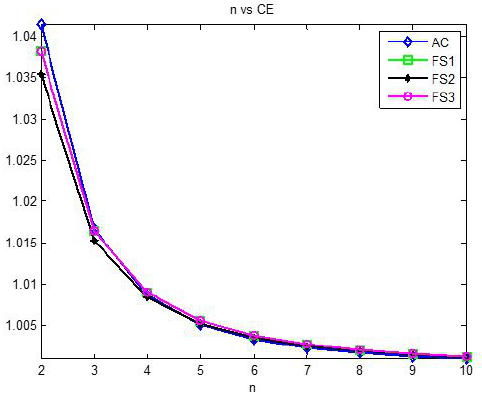
Figure 2. Comparison of Computational Efficiency for 2 (cid:54) n (cid:54) 10.